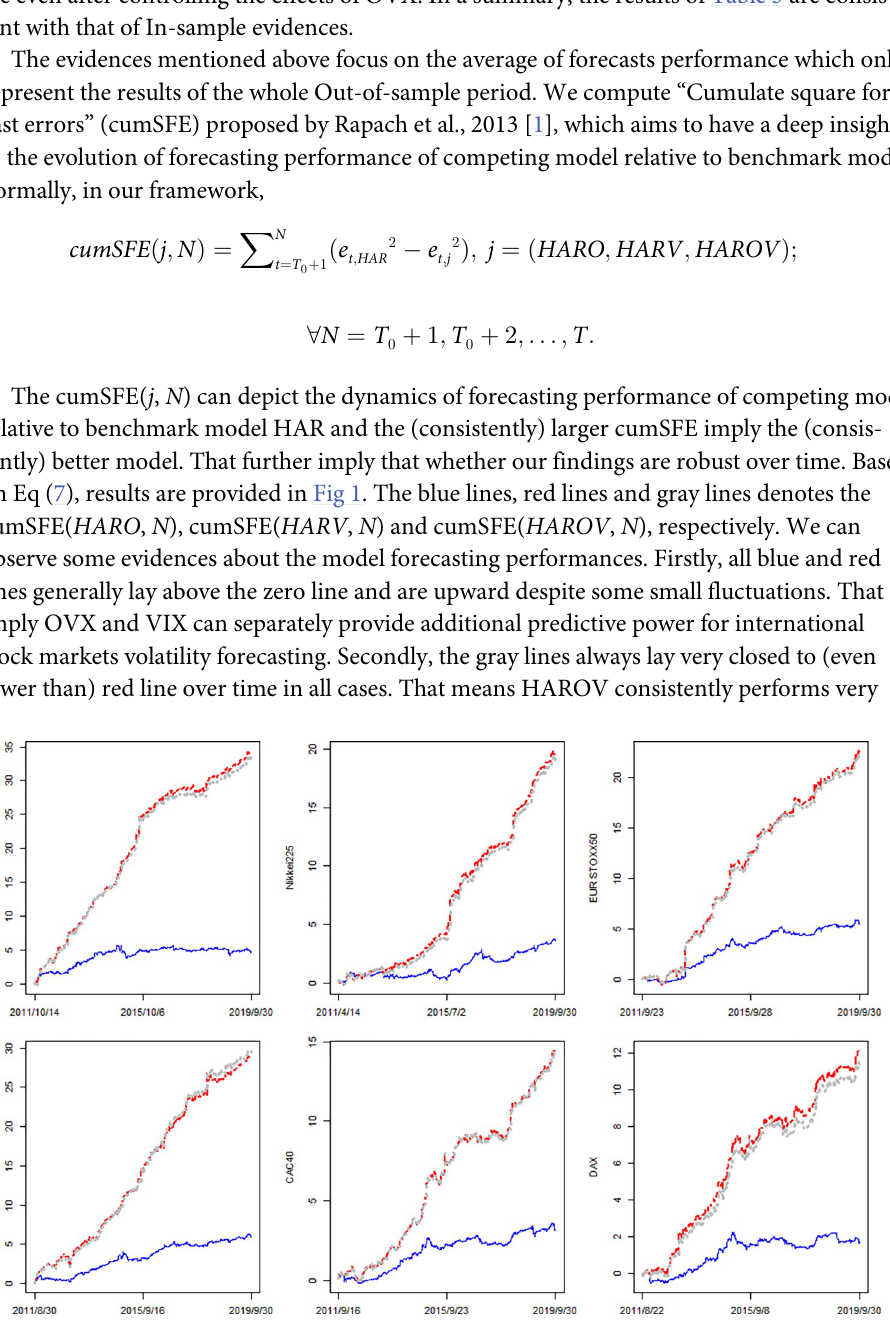
Fig 1. The cumSFE of HARO, HARV and HAROV relative to HAR. Notes: The blue line, red line and gray line denotes the cumSFE( HARO , N ), cumSFE( HARV , N ) and cumSFE( HAROV , N ), respectively.